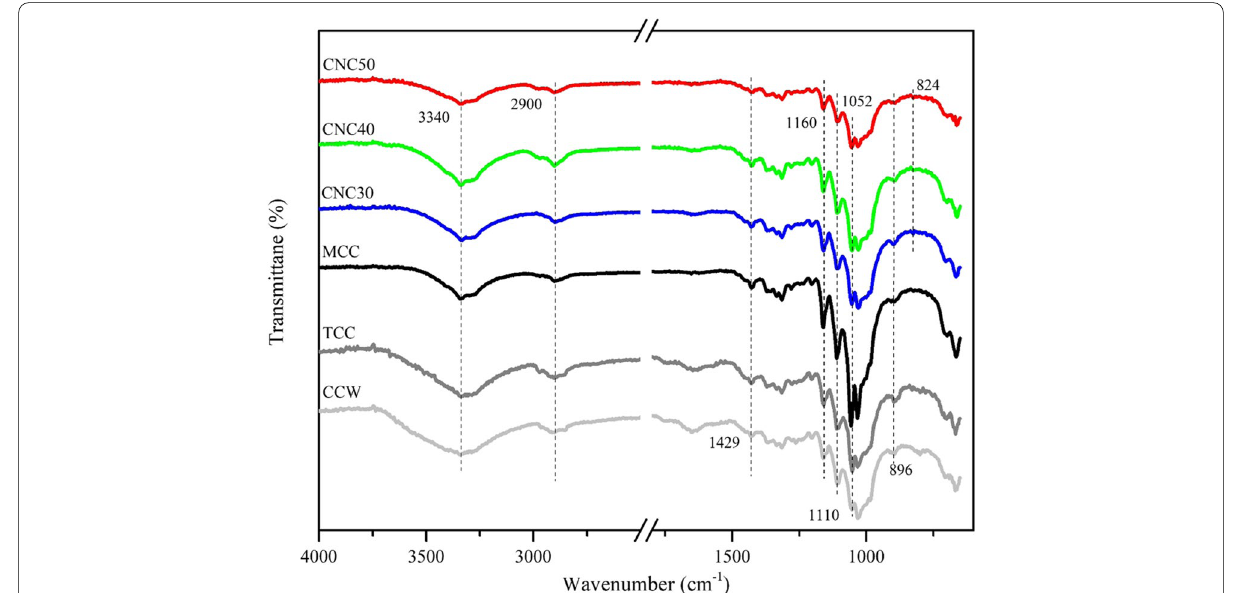
Fig. 4 FTIR of CCW, TCC, MCC and CNC